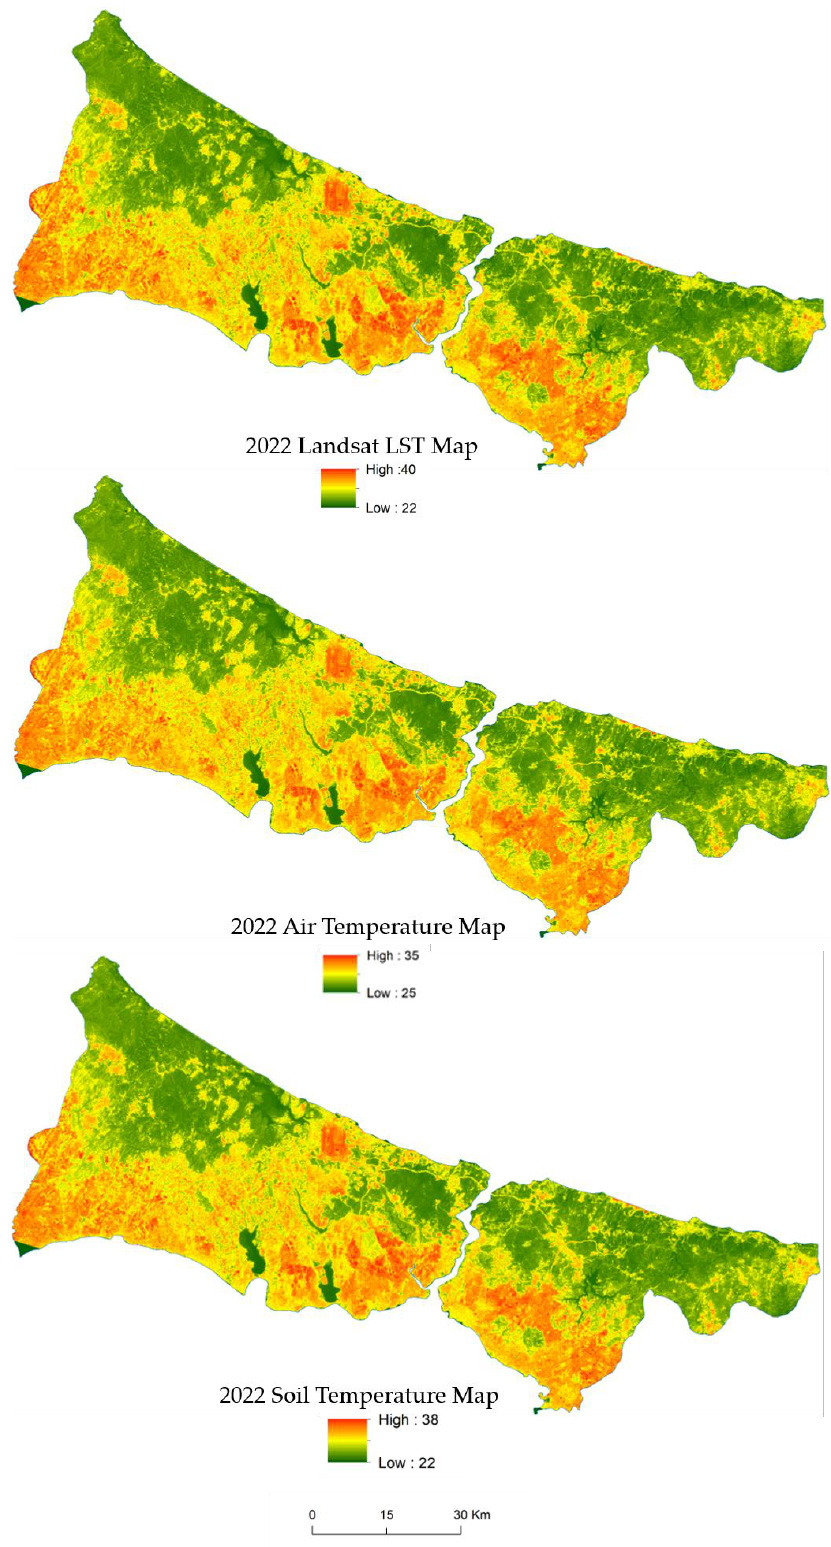
Figure 7. Landsat LST (°C) map dated on 23 July 2022 and thematic maps (air temperature and soil temperature) derived from regression models (for 09:00 a.m. UTC).